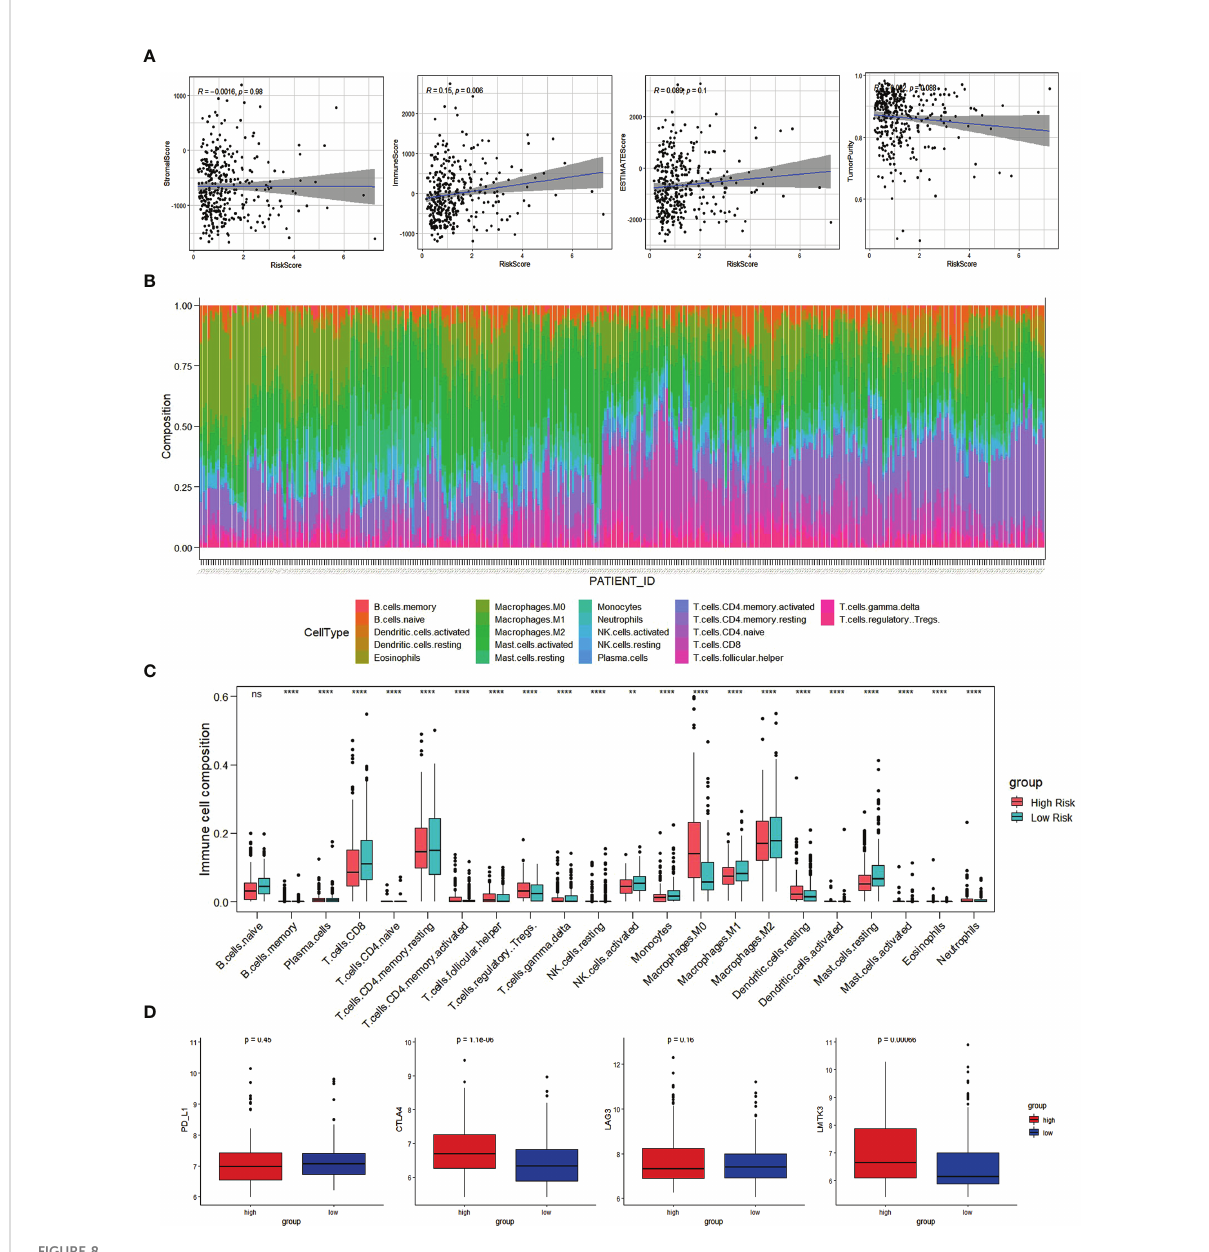
FIGURE 8 Immune cell in fi ltration analysis. (A) The correlation of Risk score with ESTIMATE analysis in HCC. (B) Histogram of the proportion of 22 immune cells in HCC samples. (C) The expression of 22 immune cells in low-risk and high-risk groups based on the TCGA dataset. (D) Comparisons of immune regulatory molecules in low risk and high-risk groups. *p<0.05; ** p<0.01; *** p<0.001; ns, not